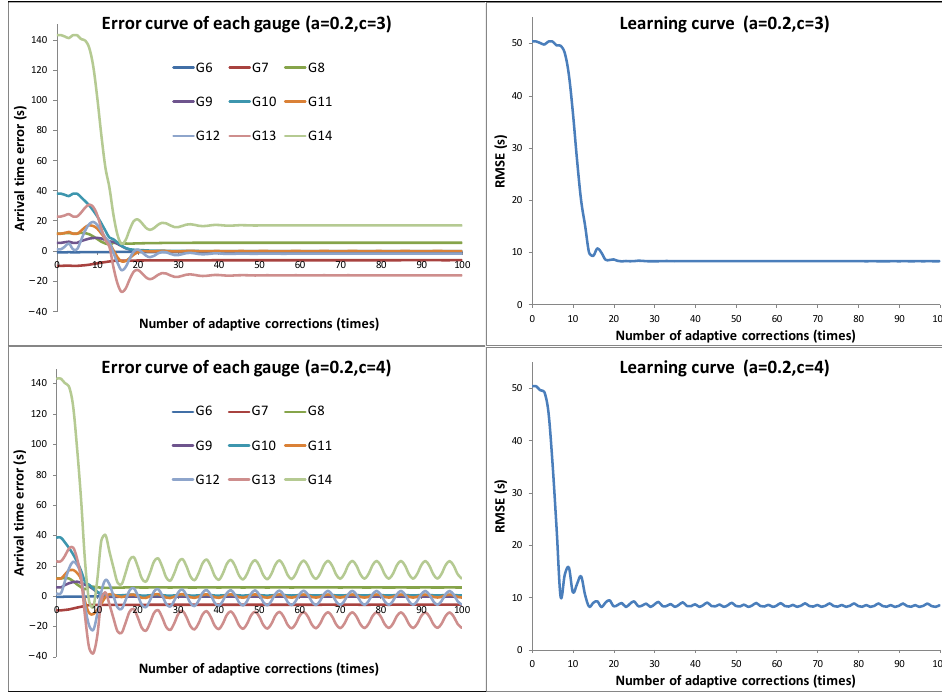
Number of adaptive corrections (times) Figure 13. Error curve and learning curve of each gauge in logic-B ( a = 0.2, c = 3 or 4). According to Figures 12 and 13, when the relaxation factor c changes from 2 to 4, according to Equation (11), the adaptive correction ∆ n becomes larger, which leads to a larger correction of water arrival time ∆ t , forming a cycle that produces the error curve and the learning curve. These curves begin to fluctuate considerably, and the larger the relaxation factor, the larger the fluctuation. The essence of this is that when the self-adaptive correction value of the Manning coefficient increases with a large step, each iteration has difficulty entering the fine-tuning area, which results in the correction process swinging back and forth in the rough-tuning area to form the oscillation. When c = 4, the fluctuations are increasingly obvious from G11 to G14. This is due to the coupling caused by the flow from upstream to downstream. Although decoupling is designed for correction logic, for such time-series events, the correction coupling at each control point can only be minimized, and not eliminated. When the relaxation factor makes the correction process unstable, this weak coupling property appears. In addition, according to the learning curve, when c is 2, 3, and 4, the speed at which the curve drops to the lowest point is approximately 16 times, 12 times, and 8 times, respectively. In summary, the relaxation factor affects the speed of adaptive correction convergence. If it is too high, fluctuations occur. Therefore, it is critical to set an appropriate relaxation factor.